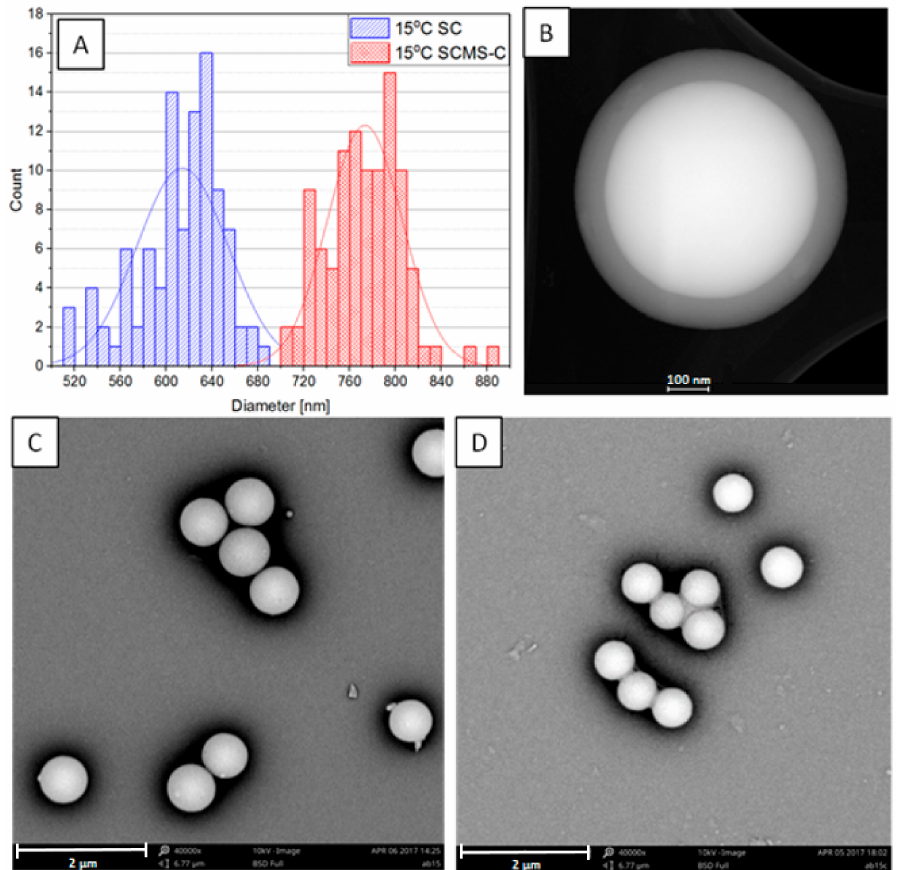
Figure 1. ( A ) Distributions of the diameters of 15 ◦ C-SCMS-C and 15 ◦ C-SC particles as determined from their respective SEM images; ( B ) STEM HAADF image of 15 ◦ C-SCMS-C; ( C ) SEM image of 15 ◦ C-SCMS-C; and ( D ) SEM image of 15 ◦